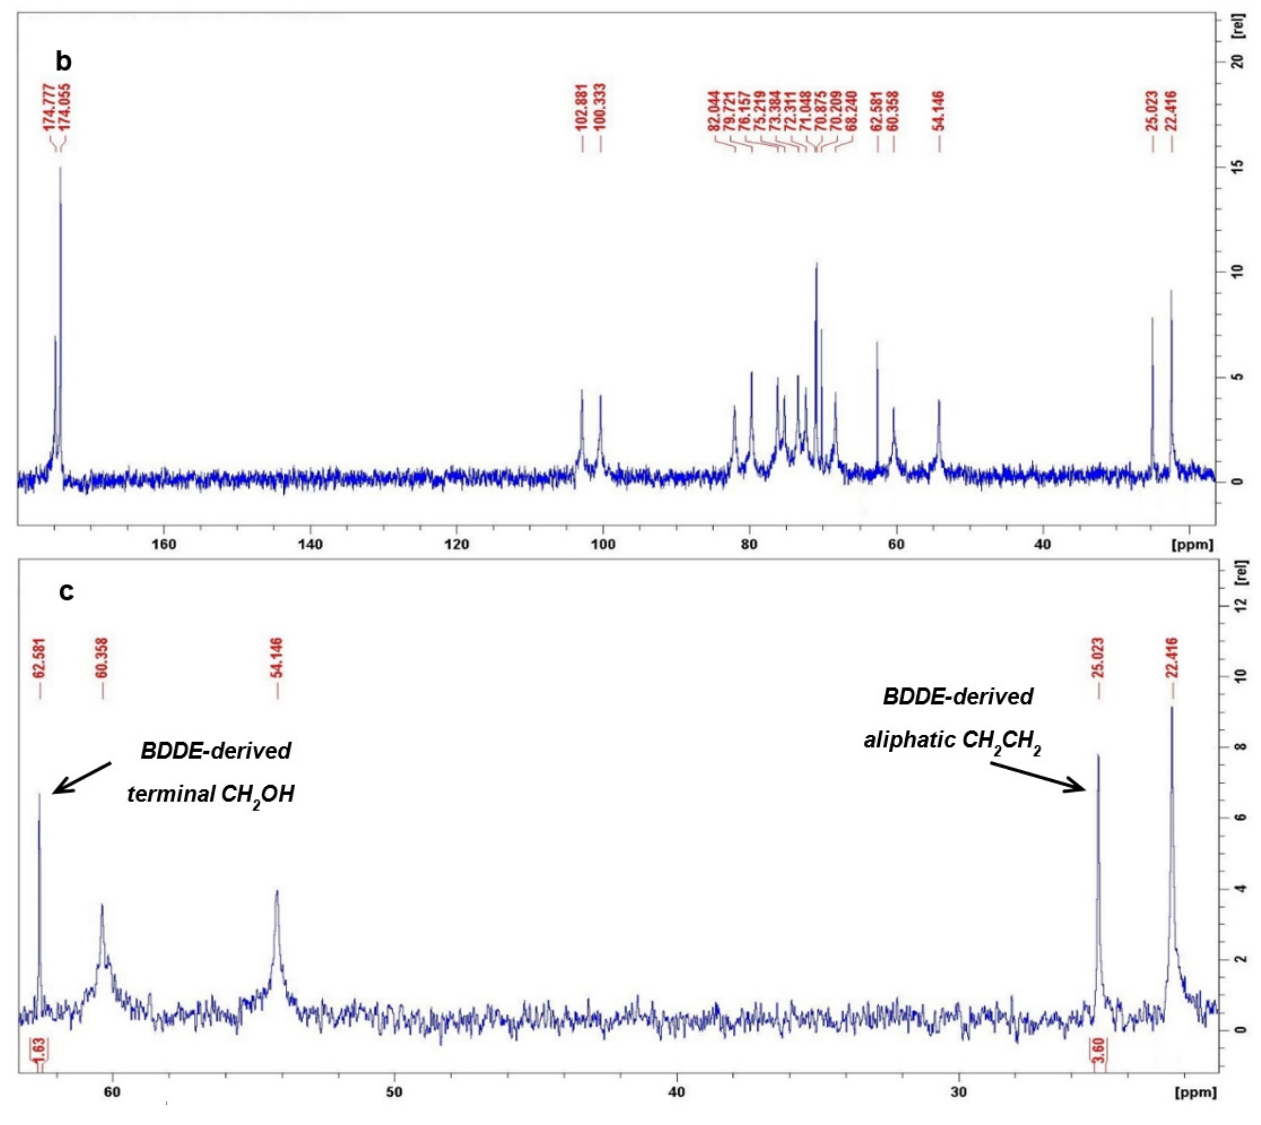
Figure 2. Representative NMR spectra. ( a ) 1 H-NMR (400 MHz, 300 K, D 2 O) and ( b ) full and ( c ) zoomed 13 C-NMR (400 MHz, 300 K, D 2 O) spectra of the ASV sample. The signals used for the quantitative determinations are indicated.